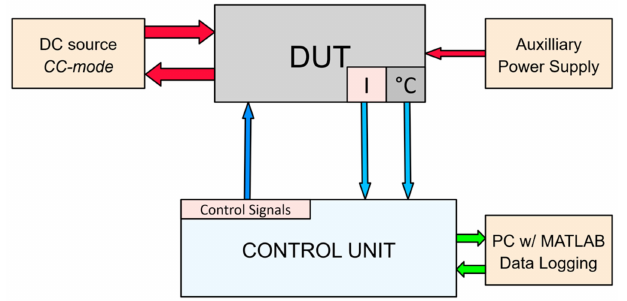
Figure 7. Block schematic of the test circuit.